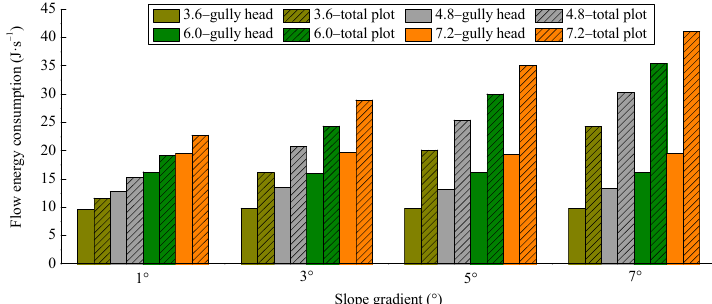
Figure 7. Flow energy consumption values of the gully head and the total plot. When the inflow discharge increased by 1.2 m 3 ∙ h − 1 , the flow energy consumption of